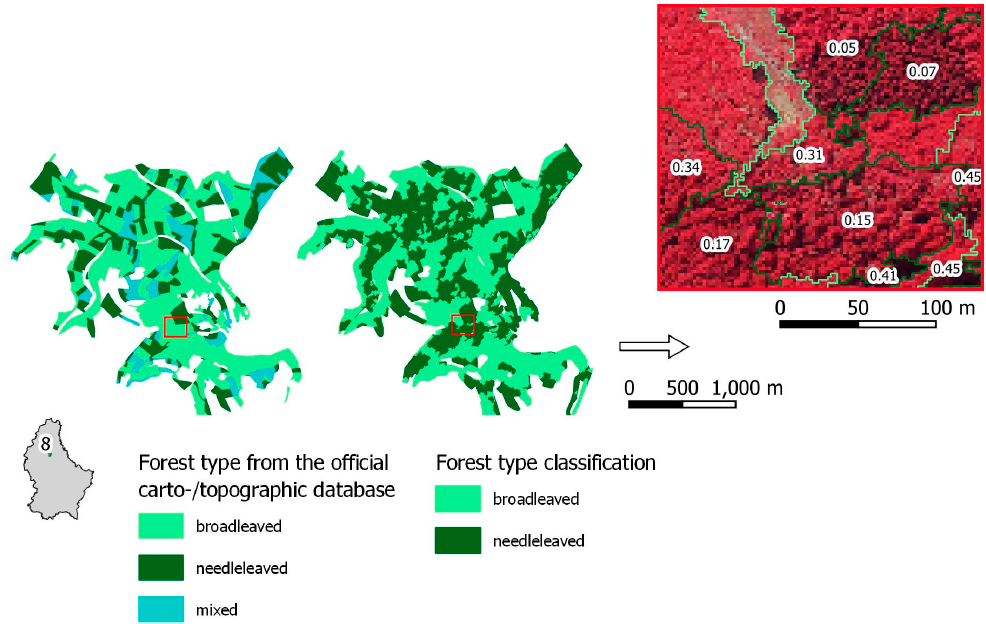
Figure 9. Comparison of forest types from the official carto-/topographic database with the best performing forest type classification for forest number 10 (Segmentation: RGB + nIR; Training: Manual; Input Features: RGB + nIR + texture) with close-ups to areas where stratification has been successful. Values indicate probability of the area to belong to broadleaved forest type class as derived from the randomForest model. ISPRS Int. J. Geo-Inf. 2020 , 9 , x FOR PEER REVIEW